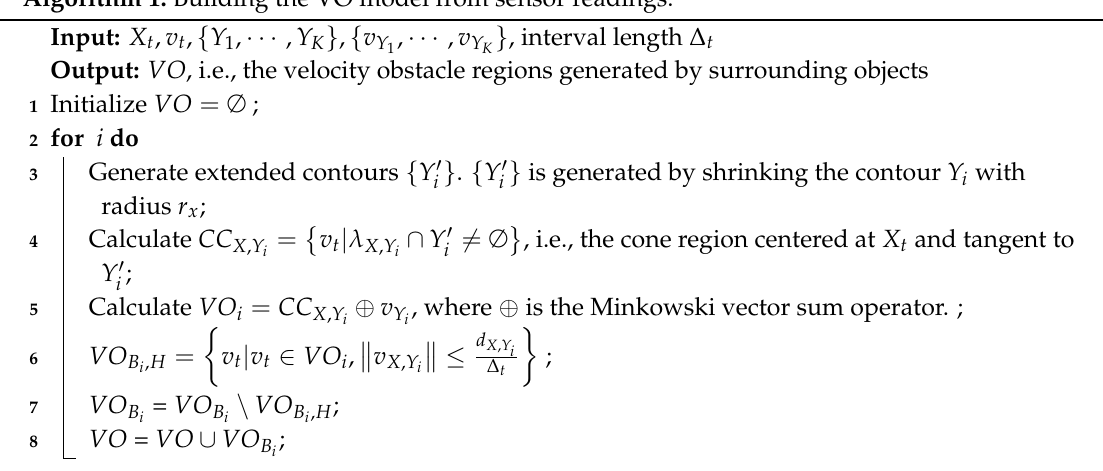
Algorithm 1: Building the VO model from sensor